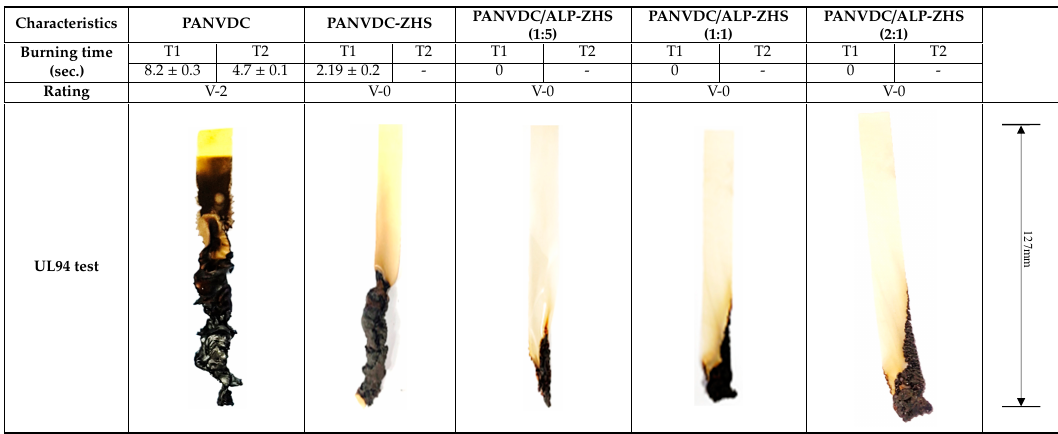
Table 2. Results of the vertical burning test (UL94) with the photographs of PANVDC, PANVDC-ZHS, and PANVDC/ALP-ZHS composites prepared at different ALP molar ratios (1:5, 1:1, and 2:1) at 50 °C for 1.5 h.